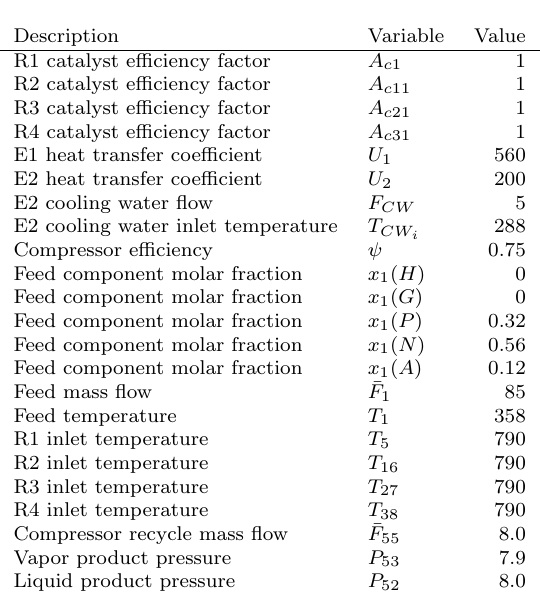
Table 3: The 23 simulation variable specifications